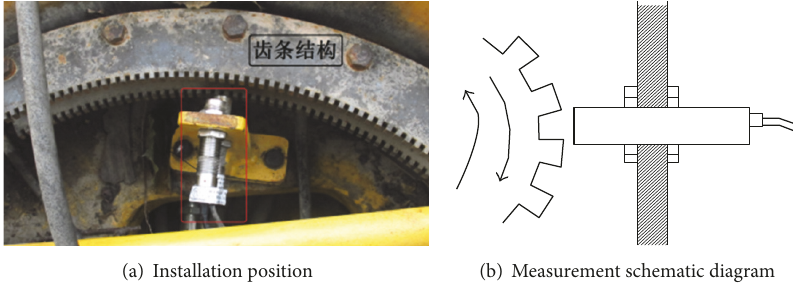
Figure 17: Installation position of dual speed sensor and measurement schematic